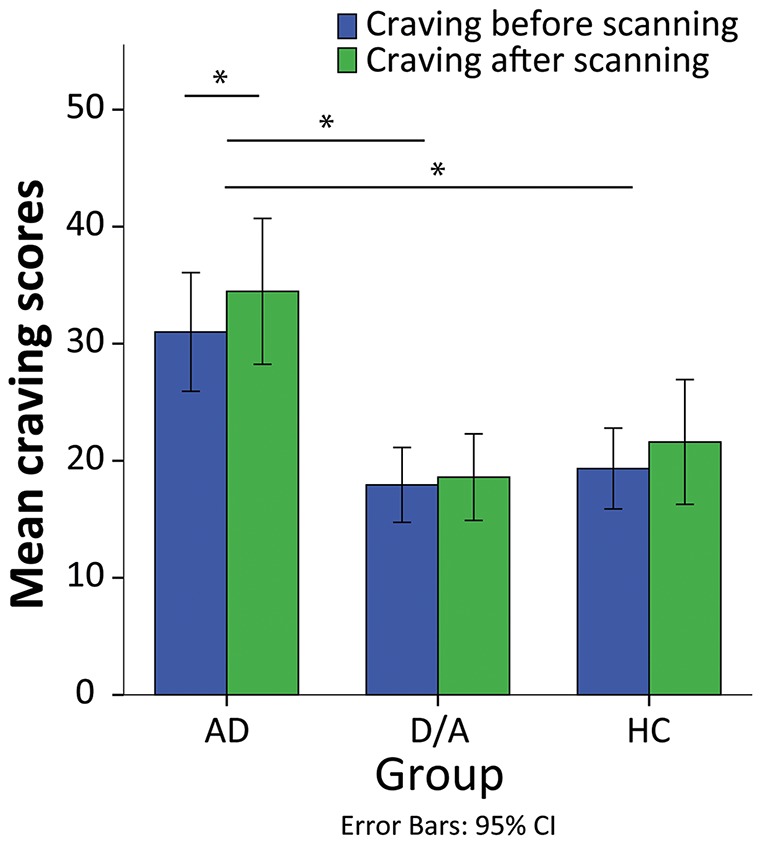
Mean craving scores before and after scanning in the three groups.The AD group showed higher craving scores compared to the D/A (P = .001) and HC (P = .003) groups. The difference between before and after was only significant for the AD group (P = .004). Abbreviations: AD, alcohol dependents; CI, confidence interval; HC, healthy controls; D/A, psychopathology controls.